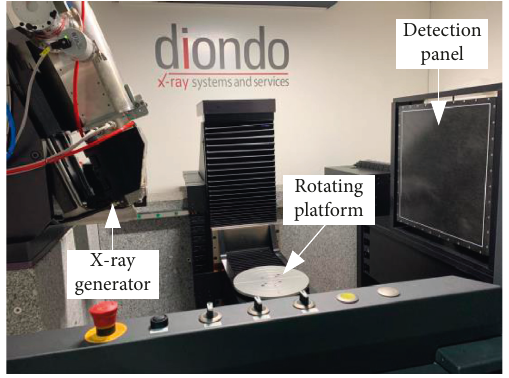
Figure 4: CT detection system.